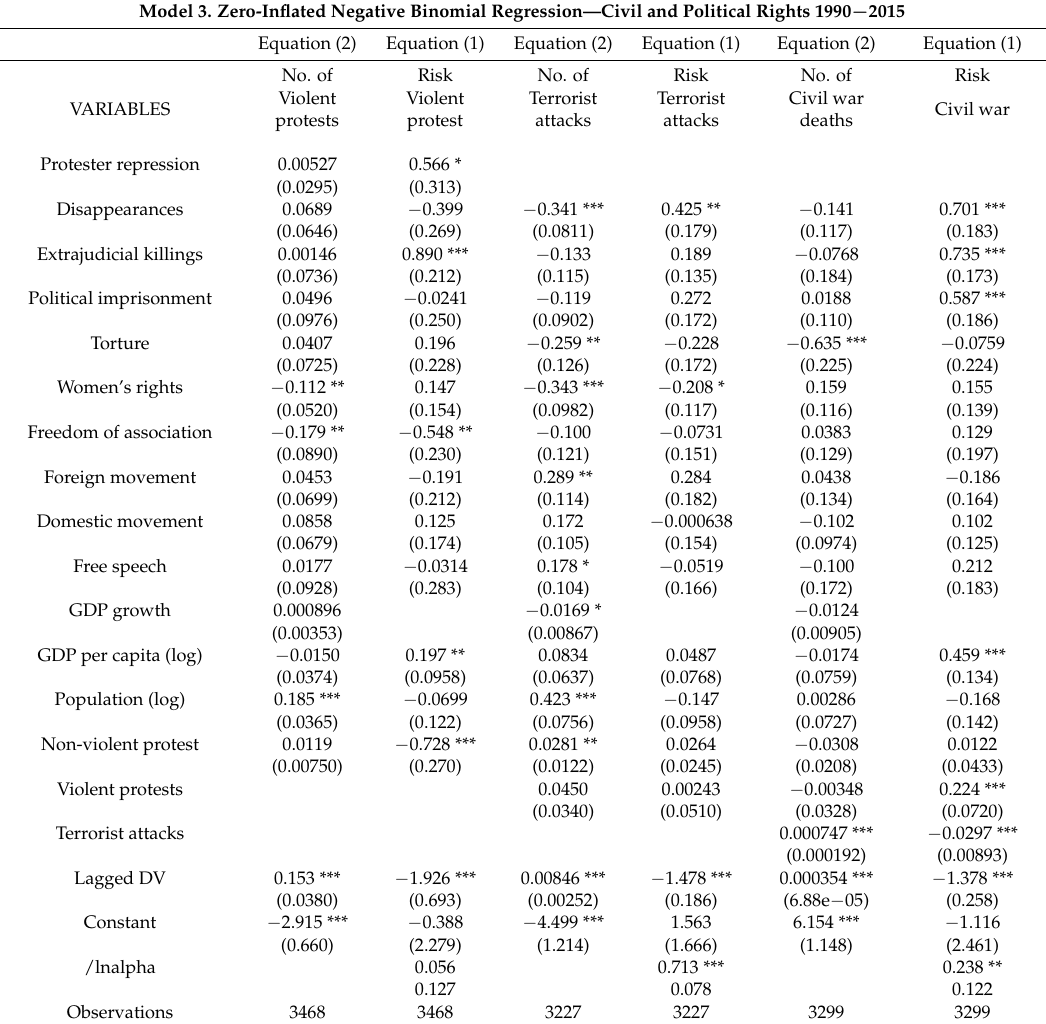
Table A5. Civil and political liberties and internal conflict, full table. Model 3. Zero-Inflated Negative Binomial Regression—Civil and Political Rights 1990 −